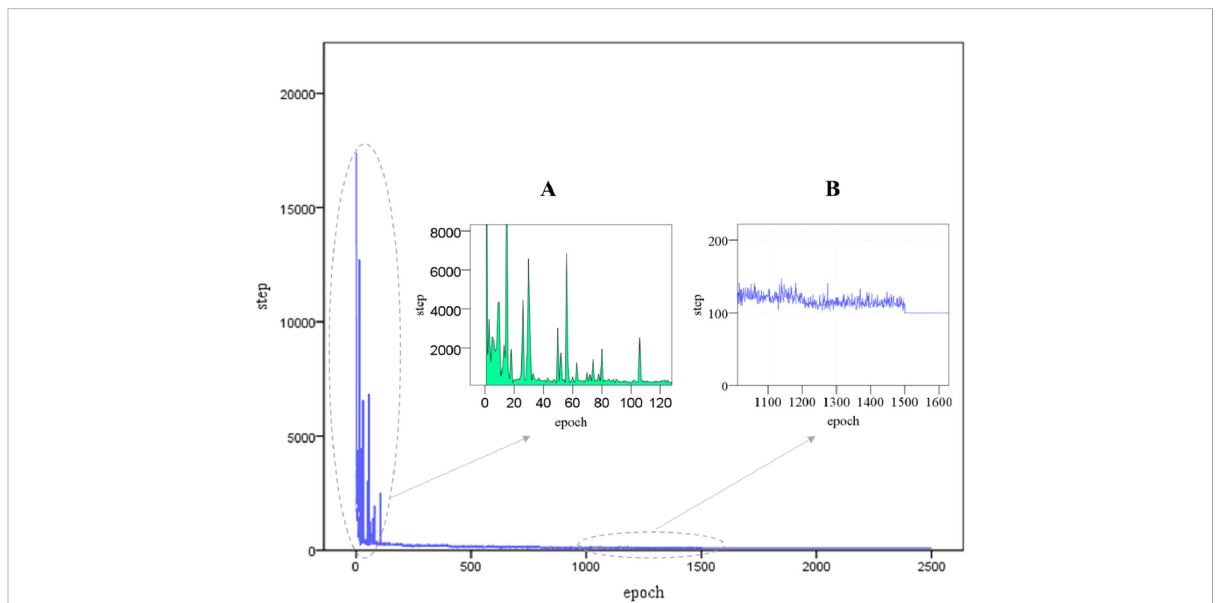
FIGURE 7 Training step variation with each epoch from the start point to the goal in simulation scenario 1, including And enlarged (A) 0-120 epochs and (B) 1100-1600 epochs two